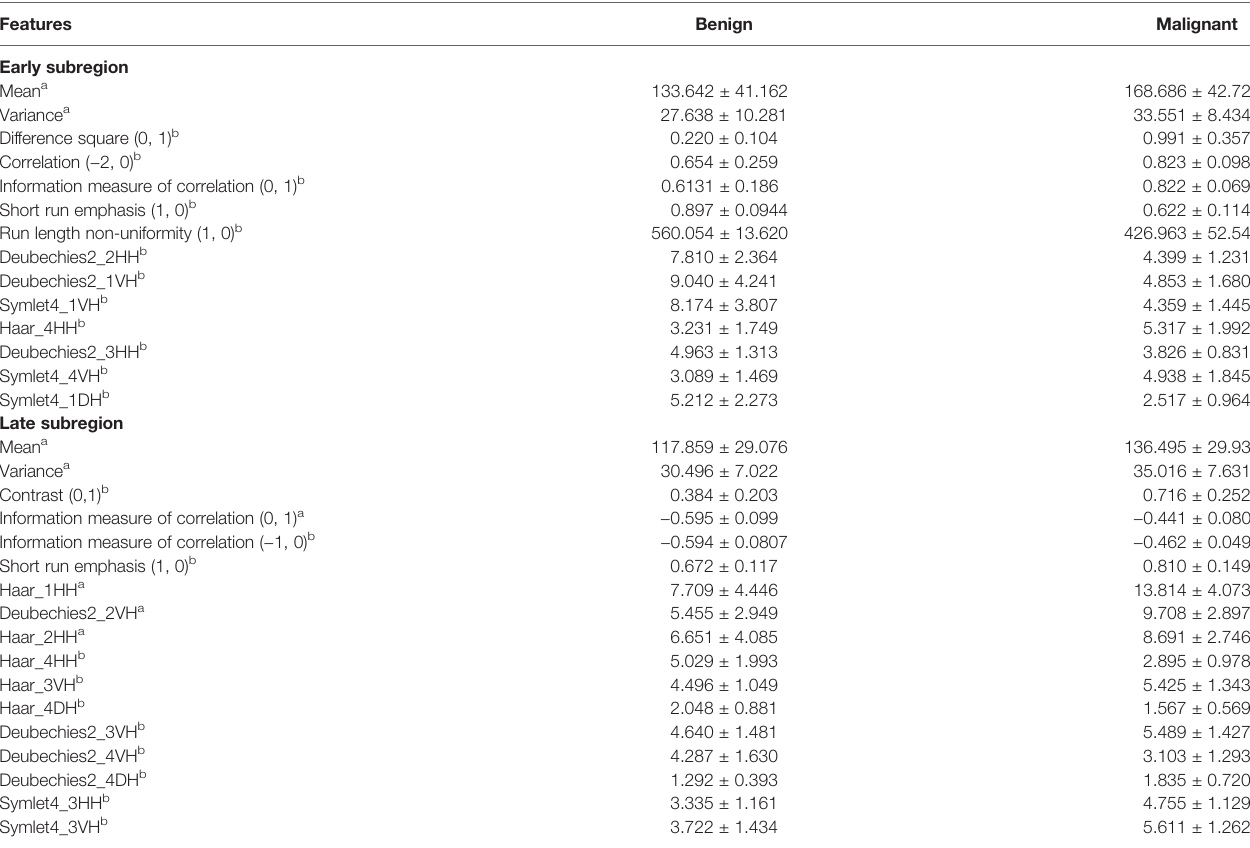
TABLE 7 | Texture features extracted from early and late subregions selected with